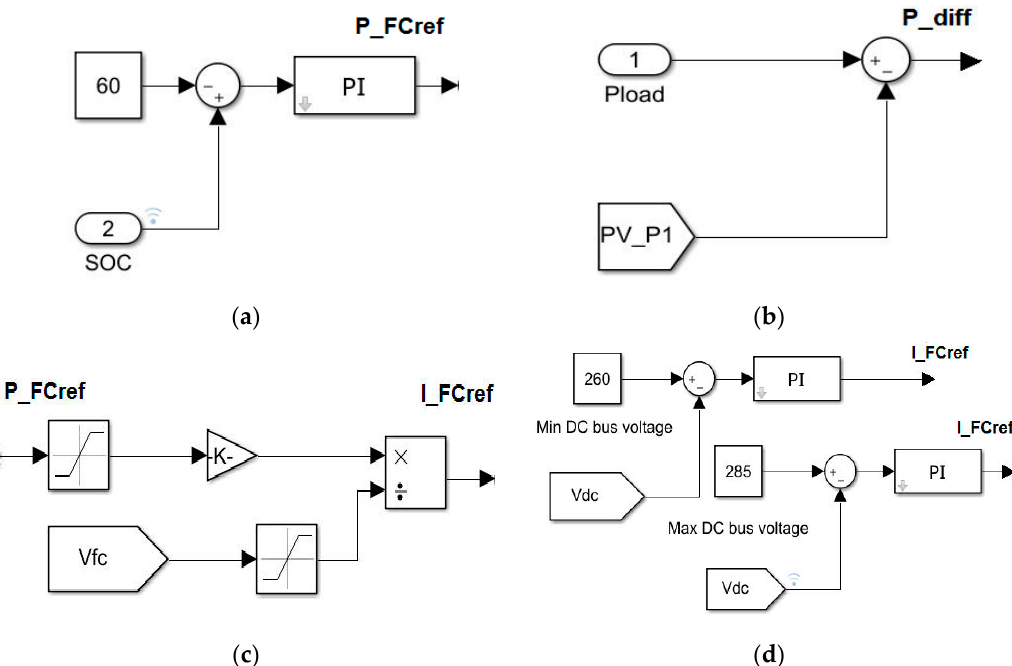
Figure 13. ( a ) State-of-charge (SOC) % check, ( b ) power shortage, ( c ) fuel cell current, ( d ) fuel cell reference current according to DC bus voltage (VDC).